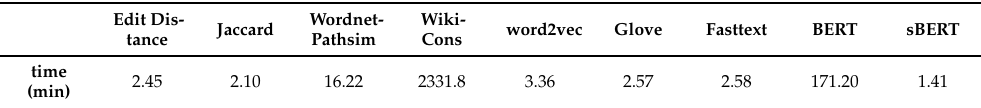
Table 6. The time consumption of different similarity calculation matchers in dataset-level match- ing process. Edit Dis- Wordnet- Wiki- tance Jaccard Pathsim Cons word2vec Glove Fasttext BERT sBERT